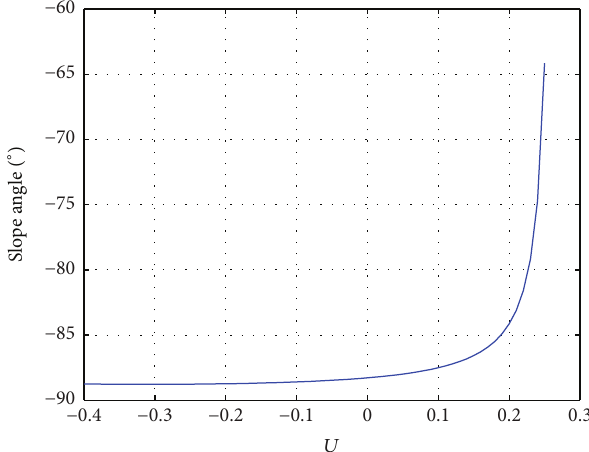
Figure 8: Slope angle of the HE steady-state characteristic.